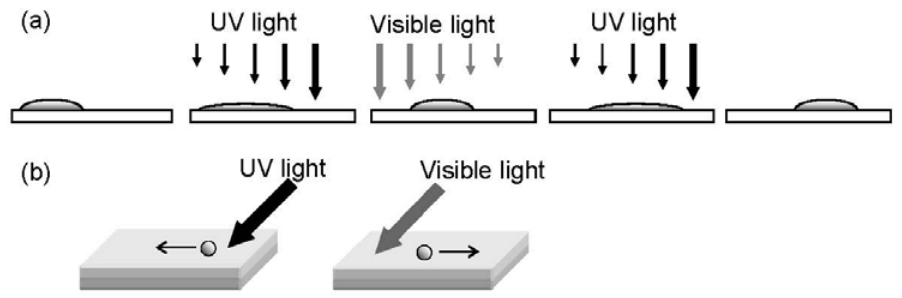
Figure 2. Light-driven motion of ( a ) liquids on a photoresponsive surface consisting of a calix-resorcinarene derivative bearing azobenzene and ( b ) a solid particle on the surface of a liquid crystalline film doped with an azobenzene